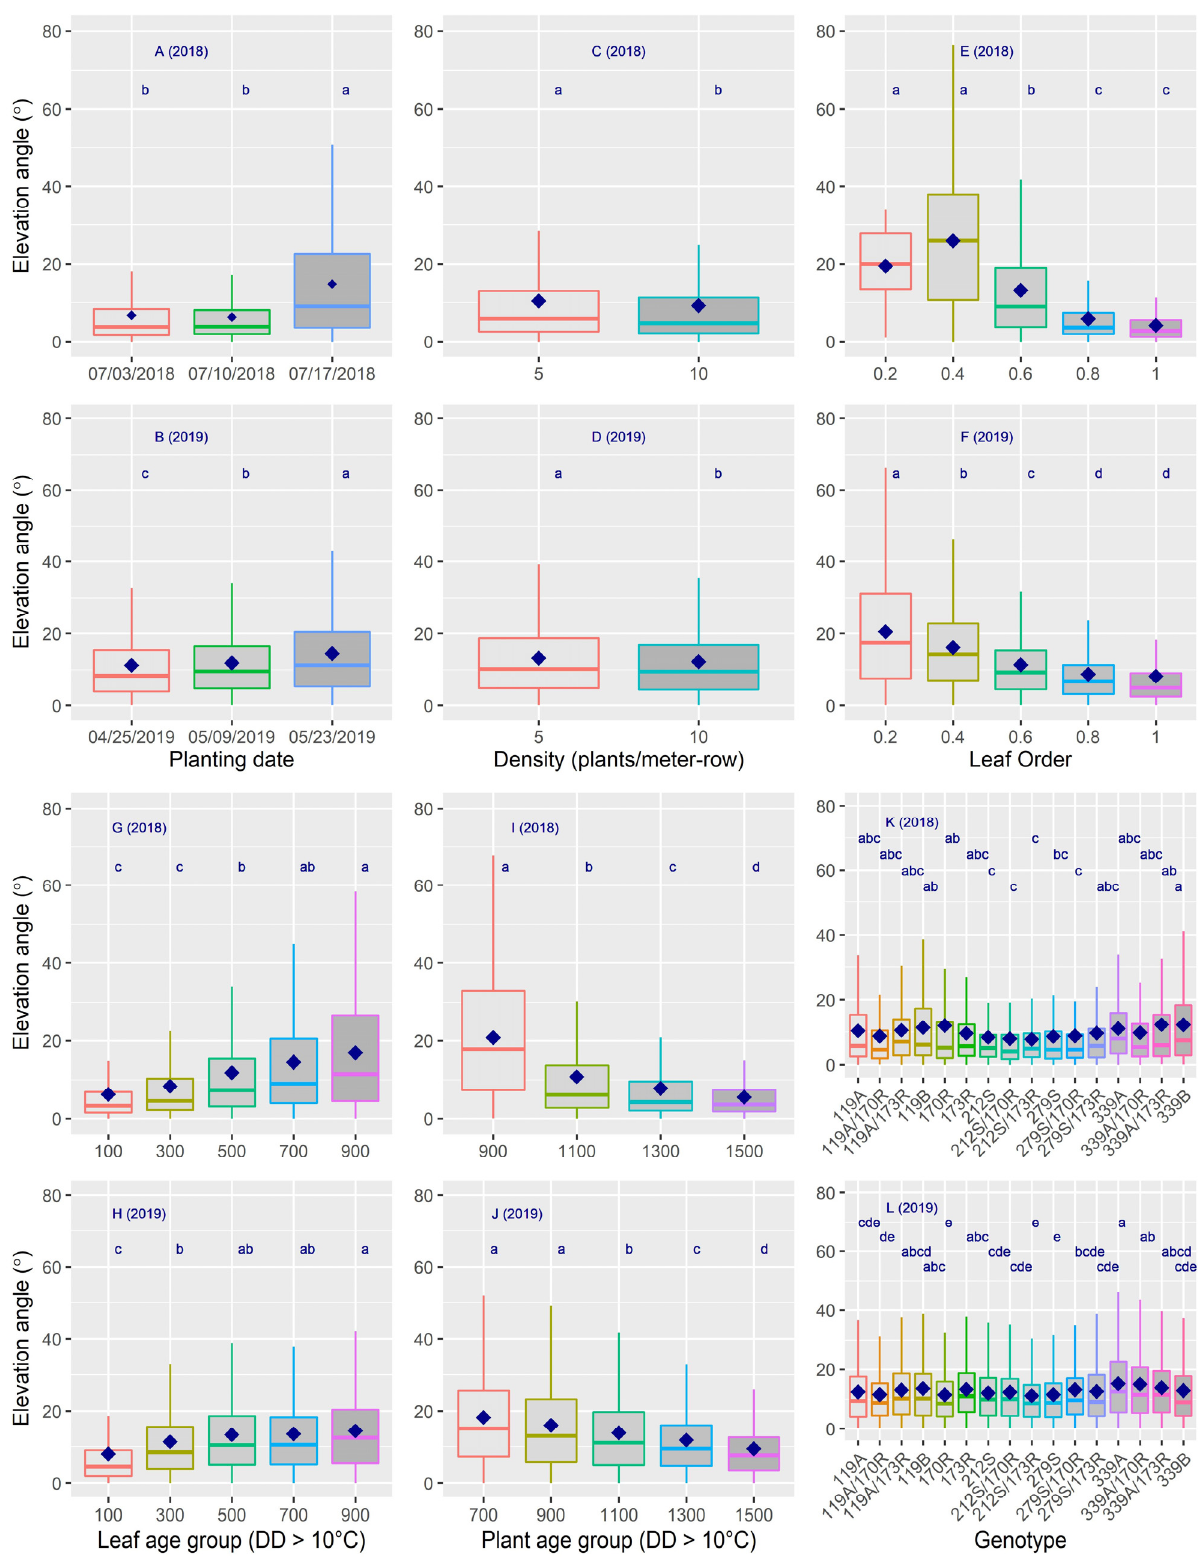
Figure 5. Elevation angle in relation to planting date ( A ): 2018 and ( B ): 2019, density ( C ): 2018 and ( D ): 2019, leaf order ( E ): 2018 and ( F ): 2019, leaf age ( G ): 2018 and ( H ): 2019, plant age ( I ): 2018 and ( J ): 2019, and genotypes ( K ): 2018 and ( L ): 2019. For each plot, categories having the same lowercase letter are not significantly different from each other at 0.05 with Tukey’s HSD multiple comparison test.